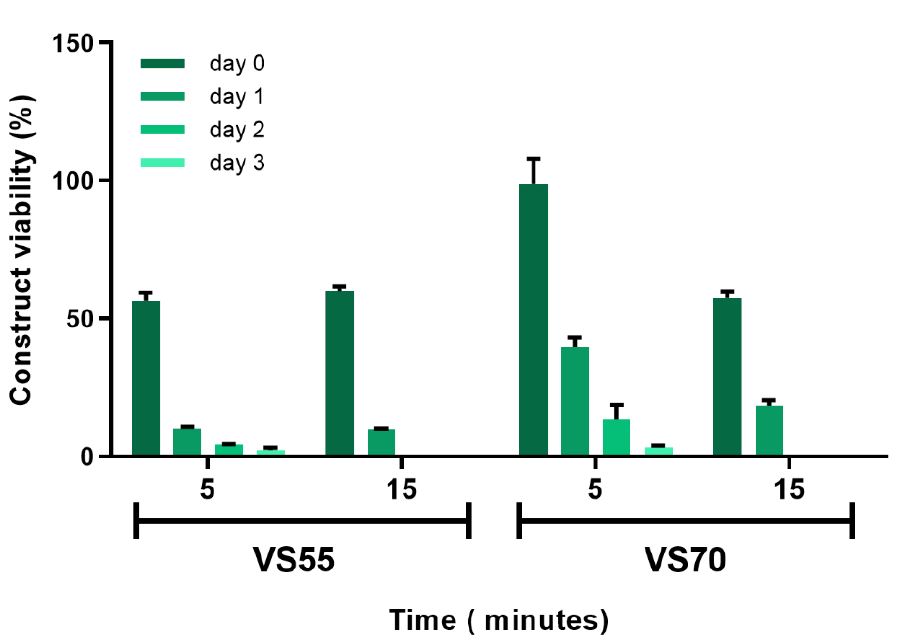
Figure 3. Viability of EpiDerm constructs after protocol modifications. Constructs were vitrified either using the original protocol for vein rings and segments that used 15 min load/unload steps with VS55 (8.4 M) [18,19,30–33] and another vitrification solution with a similar composition but higher final concentration, VS70 (10.7 M), or with shorter load/unload steps of 5 min. Viability was measured using the resazurin assay and calculated as the mean ( ± SEM) of 8 replicates. Statistical analysis performed by one-way ANOVA and Tukey’s multiple comparison test.